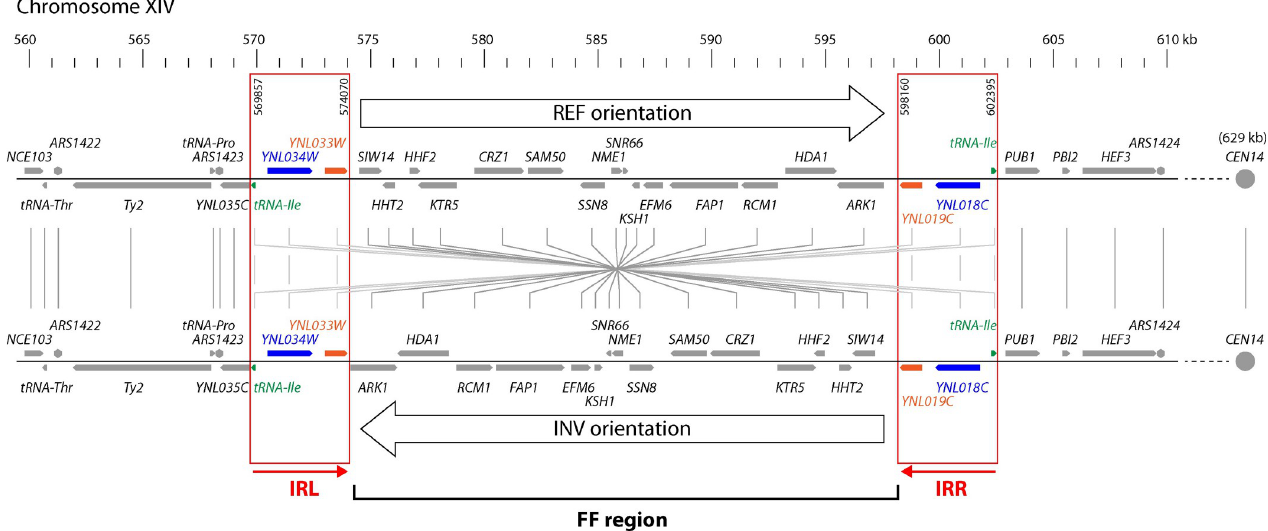
Fig 1. Organization of genes in the FF (flip/flop) region in REF and INV strains of S . cerevisiae . The IRL and IRR sequences form an inverted repeat, and recombination between them inverts the FF region. Coordinates correspond to the reference genome sequence of strain S288C, which has REF orientation.